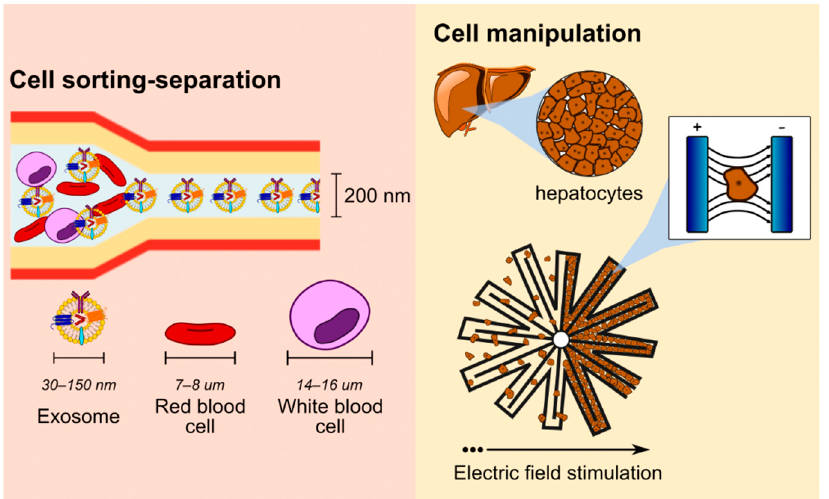
Figure 6. Schematic depiction of cell-sorting separation and cell manipulation adapting the NEMS and MEMS technology. Illustrations are adapted from mechanisms described by ref [6] and [111] , and are not-to-scale.